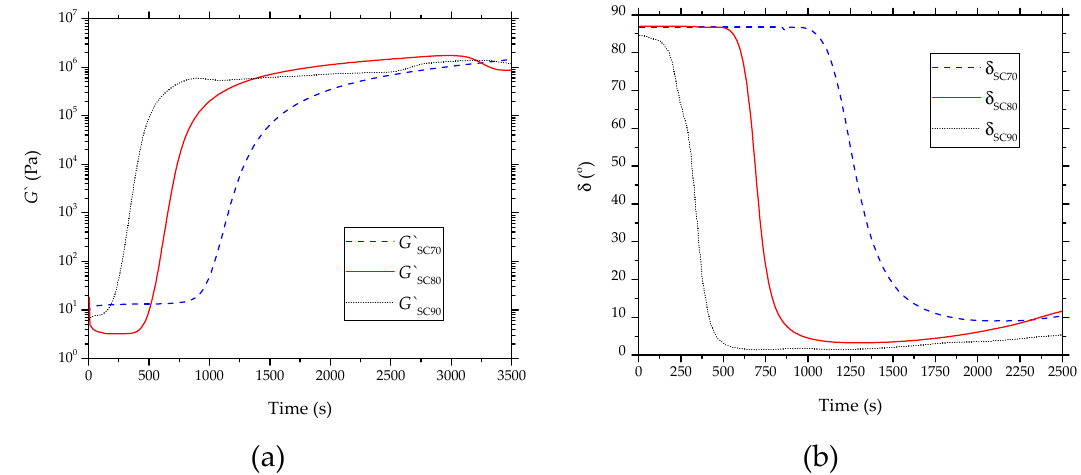
Figure 3. Evolution of ( a ) storage modulus ( G (cid:48) ) and ( b ) phase angle ( δ ) with time of the partially bio-based epoxy resins subjected to standard curing (SC) treatment, obtained by rheometry. Table 4. Gel time (t gel ), curing time (t curing ), and maximum storage modulus ( G (cid:48) max ) of the partially bio-based epoxy resins after the di ff erent curing